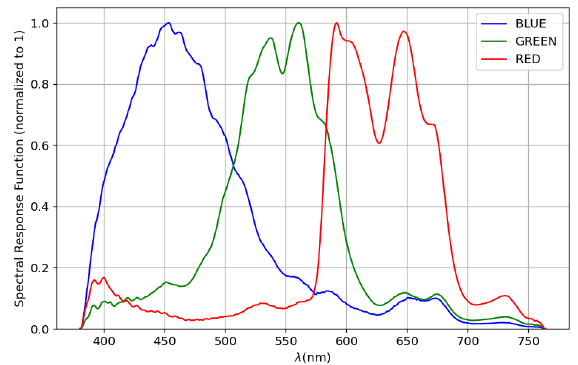
Figure 3. The spectral response